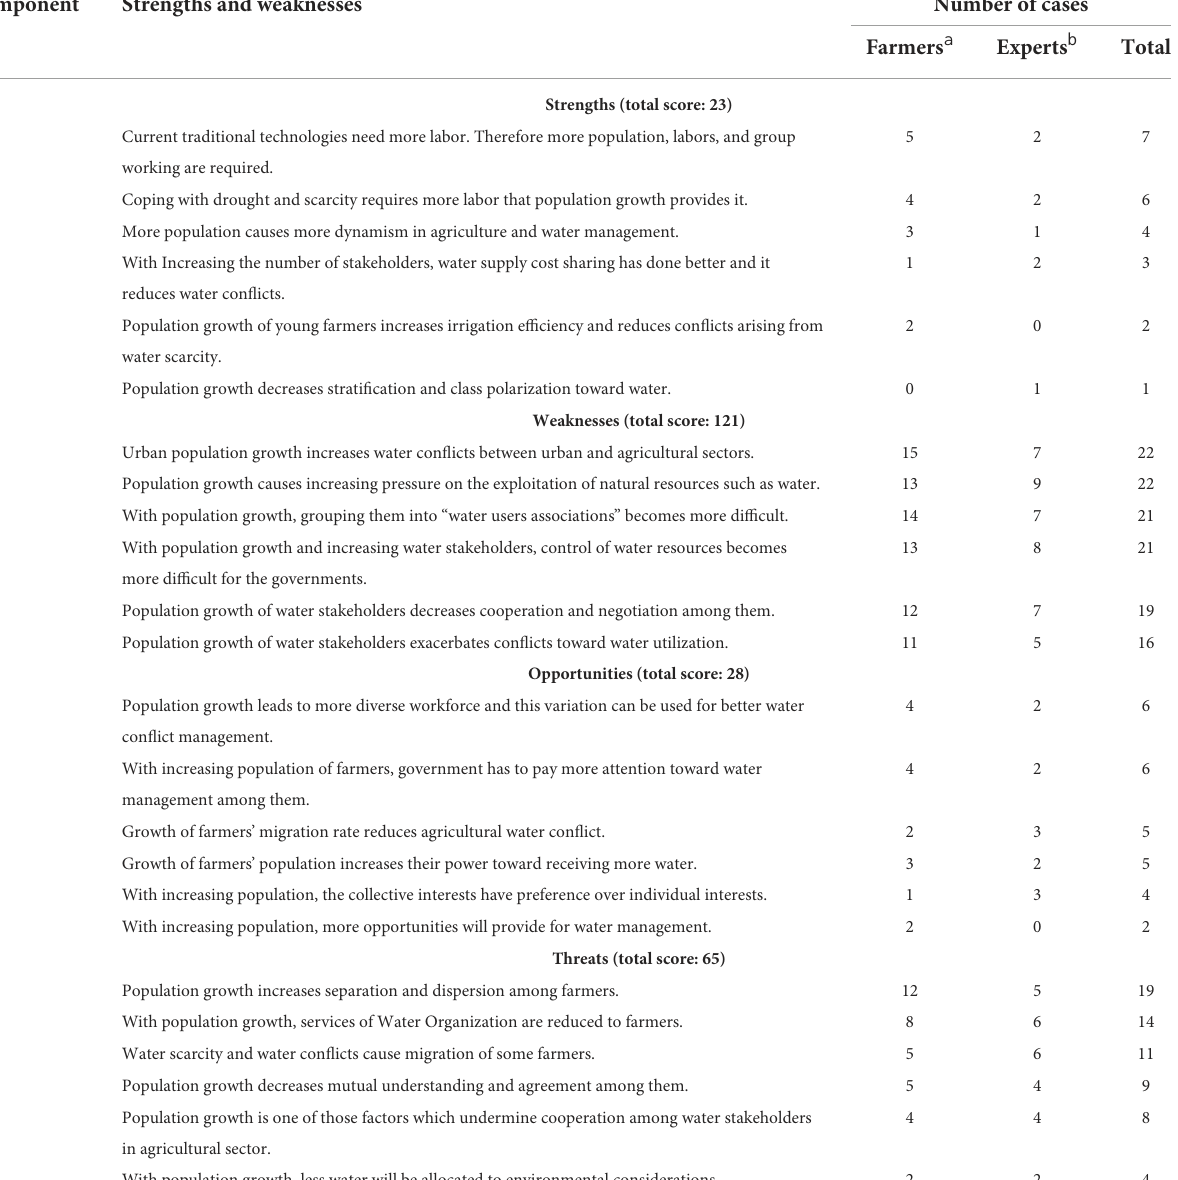
TABLE 7 SWOT matrix of population dynamics with water conflict: Opinions of farmers and experts. Component Strengths and